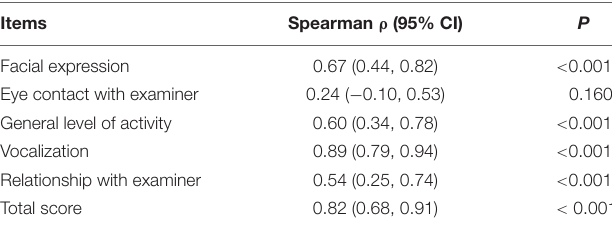
TABLE 8 | Correlation between the full and modified ADBB items in 36 Nepalese